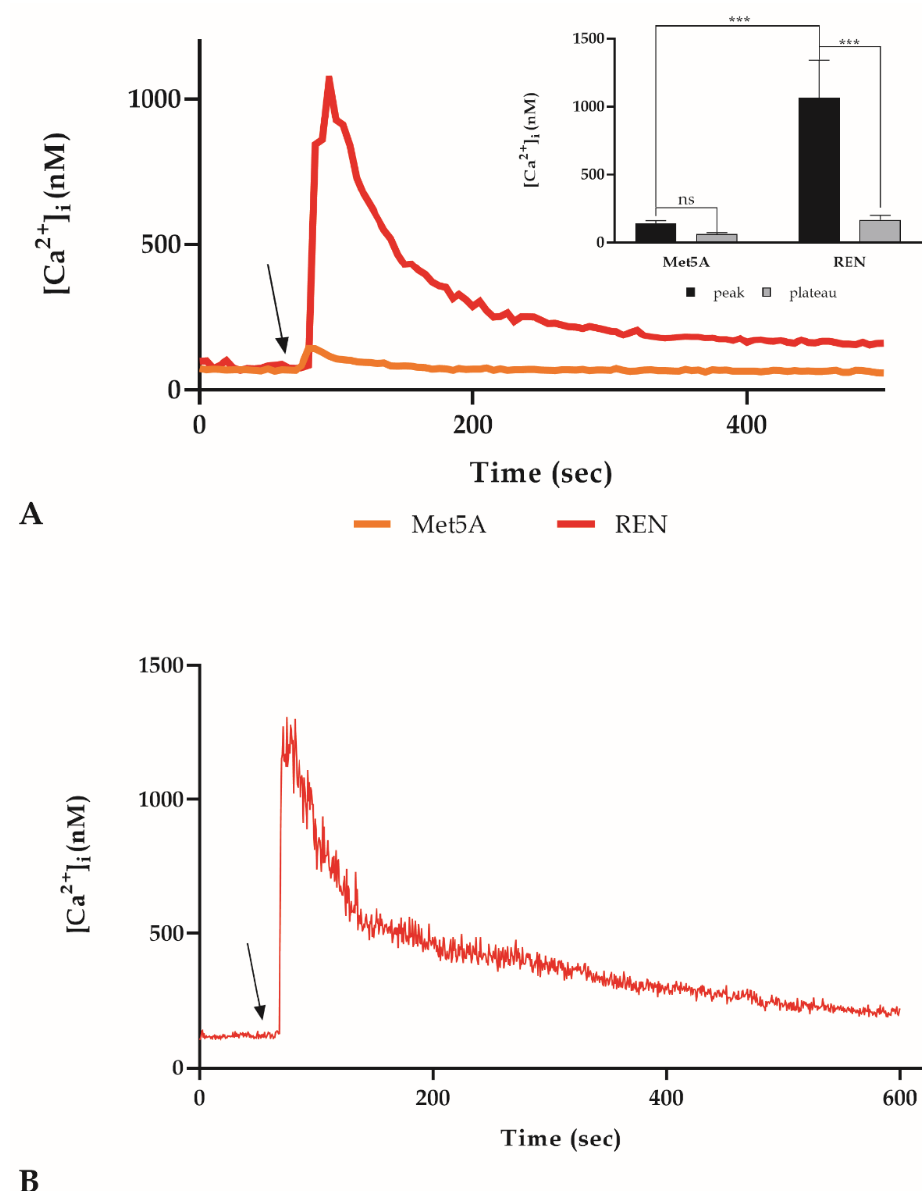
Figure 5. Variation of [Ca 2+ ] i induced by BOLD-100. ( A ). [Ca 2+ ] i modifications after BOLD-treatment recorded at 5 sec intervals in Met5A and REN cell lines. The arrow shows the BOLD-100 addition after 60 sec. Data are means of [Ca 2+ ] i traces recorded in different cells. Number of cells: 40 cells from three experiments for each cell line. Insert. Means ± SEM of Ca 2+ peak response. Number of cells as before. Statistics indicate differences between Met5A and REN cell line at the peak or at the plateau level (*** p < 0.001, two-way ANOVA followed by Bonferroni correction), or differences between peak and plateau for each cell line (*** p < 0.001; ns not significant, two-way ANOVA followed by Bonferroni correction). ( B ). [Ca 2+ ] i variations induced by BOLD-100 recorded at 1 sec intervals. Data are means ± SEM of [Ca 2+ ] i traces recorded in 40 different cells.